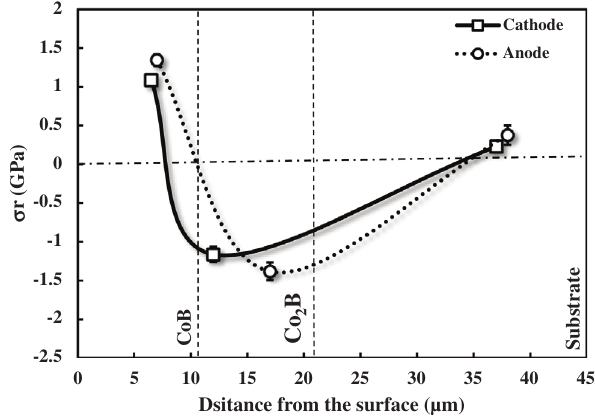
Figure 9: Distribution of the residual stresses along the depth of the cobalt boride layers. The PBDCF condition was 1148 K with 2 h of